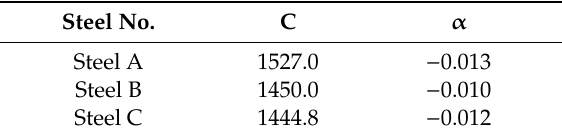
Table 2. The material constants C and α for steels A, B, and